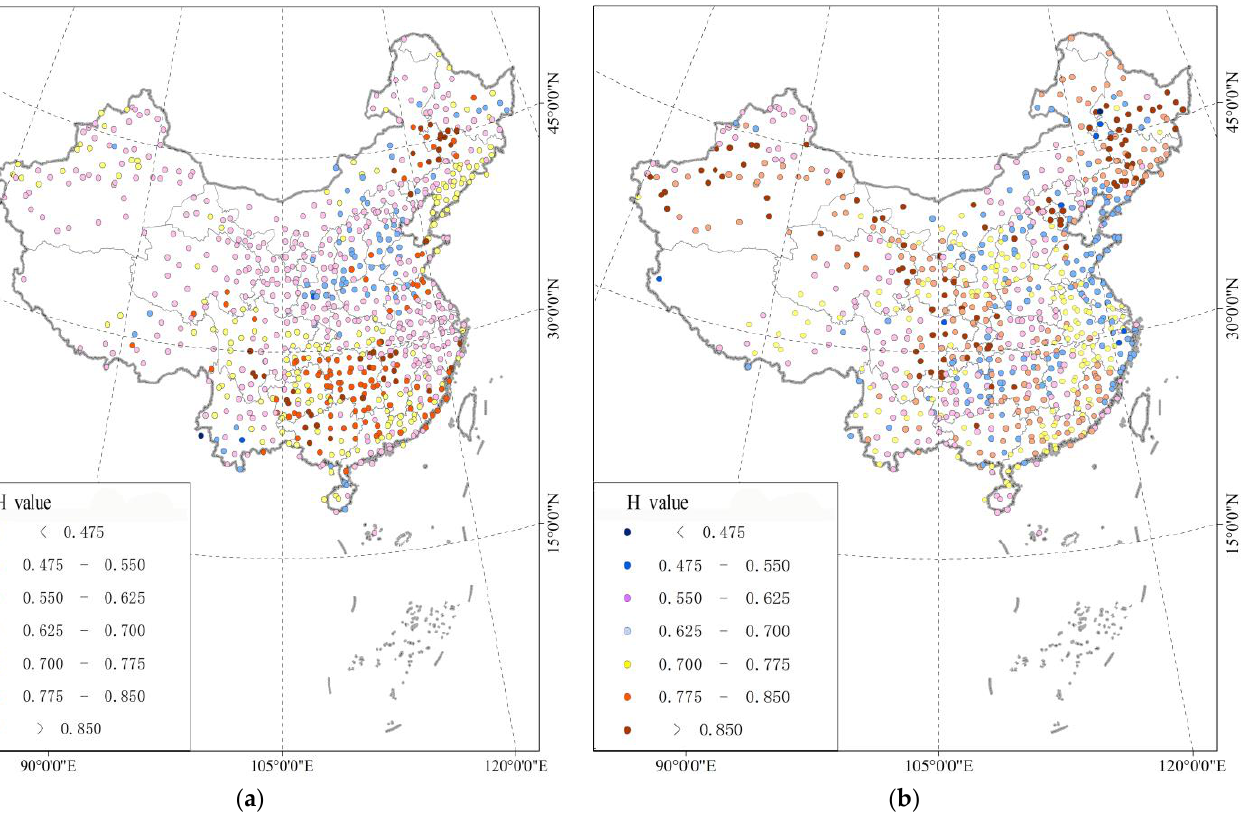
CTNn. Figure 12. Spatial distribution of H values for CTXx and CTNn from 1966 to 2015. ( a ) CTXx. ( b )